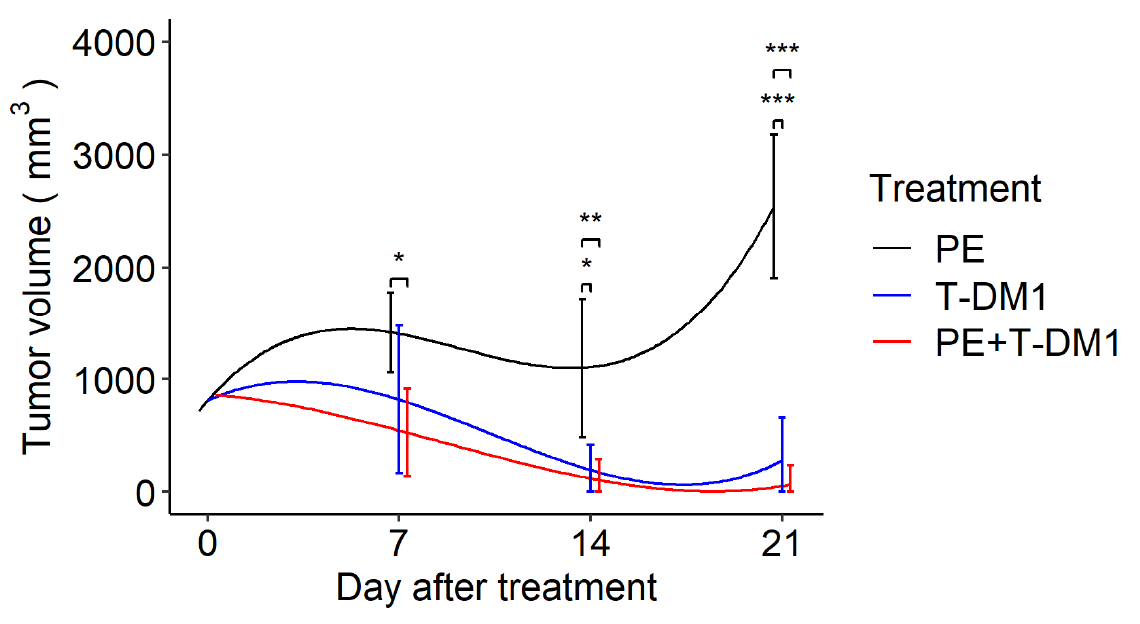
Figure 3. A drug/filtration combination increases the removal of EVs and enhances tumor shrinkage by T-DM1. Longitudinal marginal means of the tumor volume after the tumor size reached approximately 10 mm in diameter with treatment by plasma exchange, T-DM1, and plasma exchange with T-DM1 ( n = 12 in each group) based on the linear mixed model. PE: plasma exchange, T-DM1: trastuzumab emtansine. Error bars indicate confidence intervals; * p < 0.05, ** p < 0.01, *** p < 0.001 .